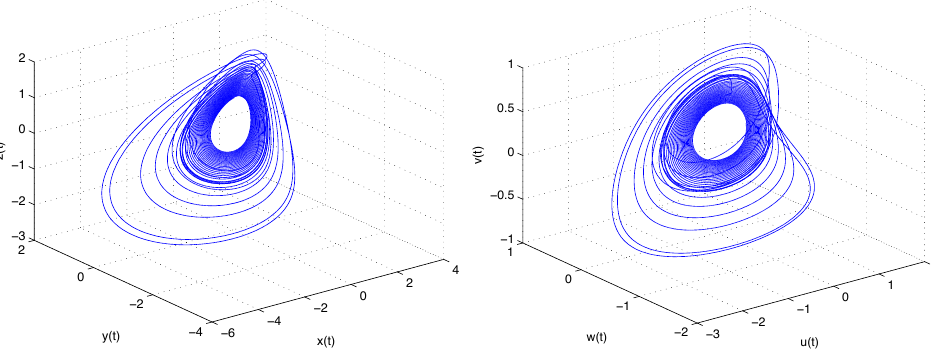
Figure 6. One-scroll attractors of the system (22) in state space x − y − z ( left ) and u − w − v ( right ).